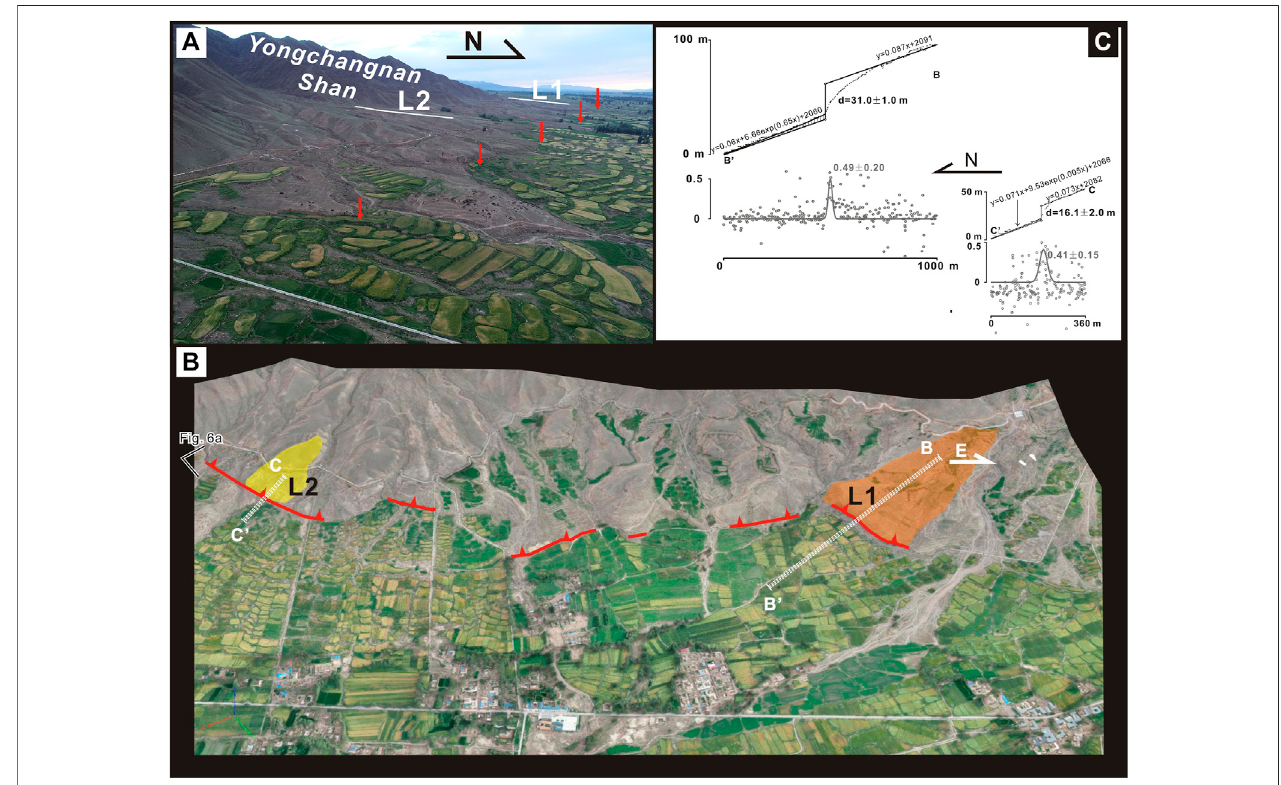
FIGURE 6 | (A) Aerial photography of the Luban temple site. The red line shows the fault track. (B) 3D topography of the surveyed site. The derived topographic pro fi les B-B ′ and C-C ′ are normal to the fault strike. (C) The topographic pro fi les show the vertical throws of L1 and L2. The Gaussian functions yield the maximum